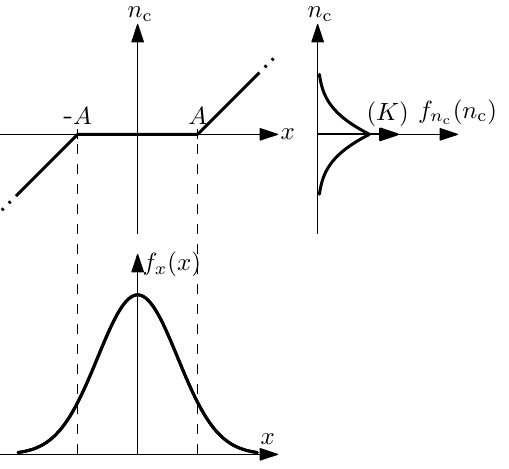
Figure 2. Transformation of the Gaussian probability density function of x over a non-linear charac- teristic to represent the probability density function of n c